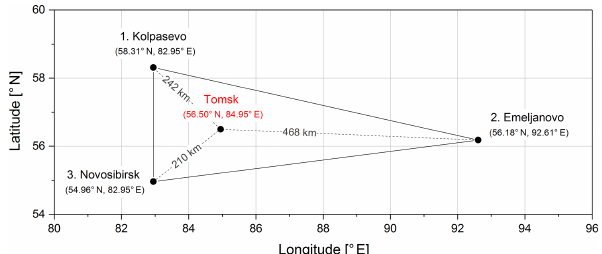
Figure 1. Three neighboring meteorological stations (with the dis- tances between them and Tomsk) launching radiosondes twice a day. The stations are numbered for